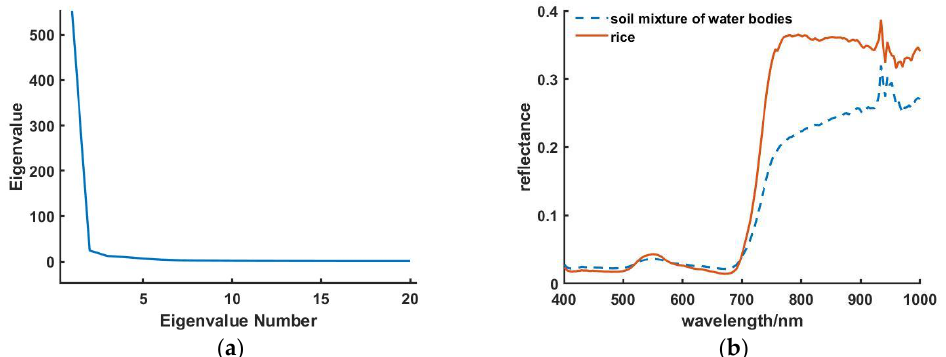
Figure 2. Extraction of the end-element hyperspectral image of the rice fields: ( a ) MNF rotation to determine spectral feature dimensions; ( b ) terrestrial end-element hyperspectral image.